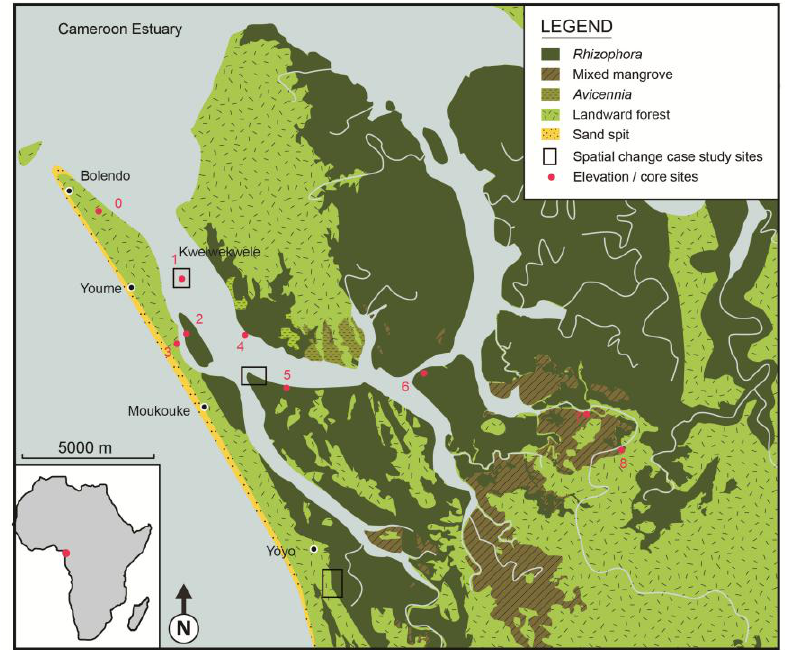
Figure 1. Cameroon Estuary southern mangrove area showing mangrove species zones and locations of spatial change case study